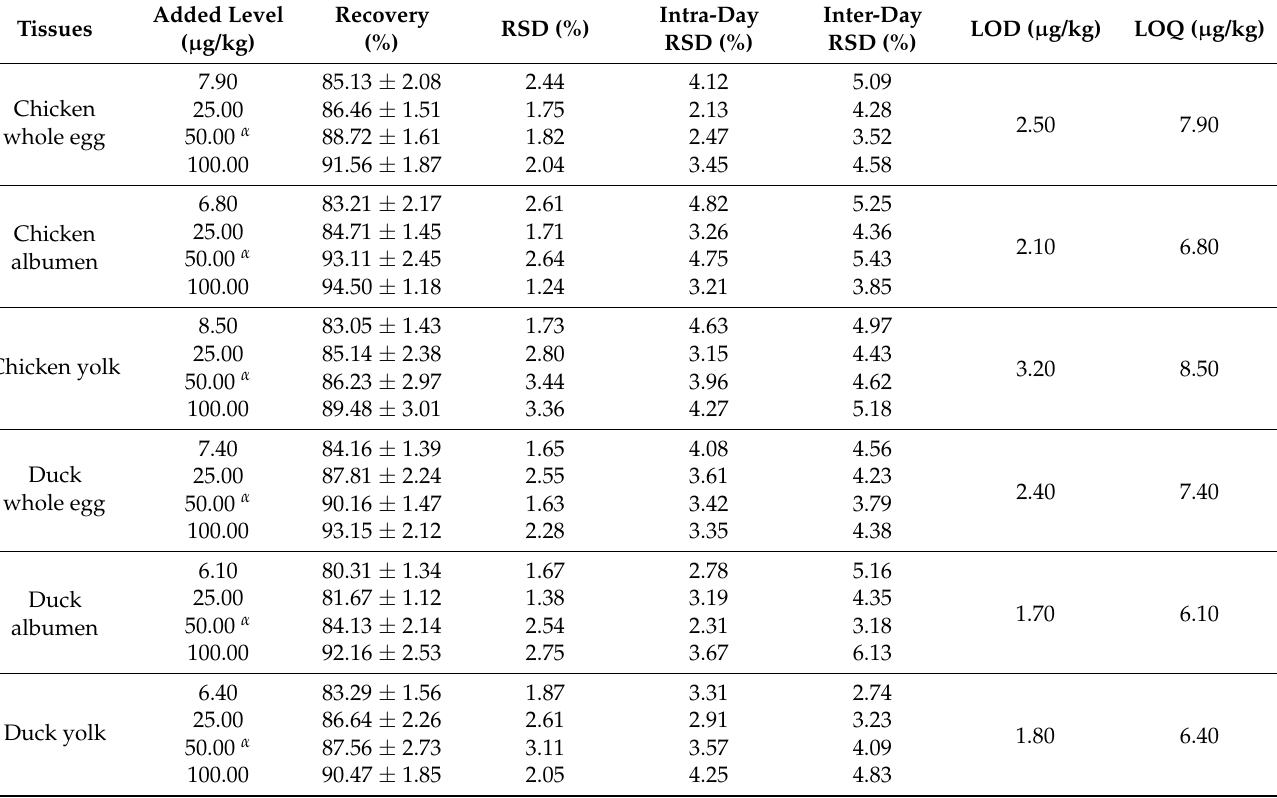
Table 4. Recovery and precision of penicillin G added to blank poultry eggs ( n =